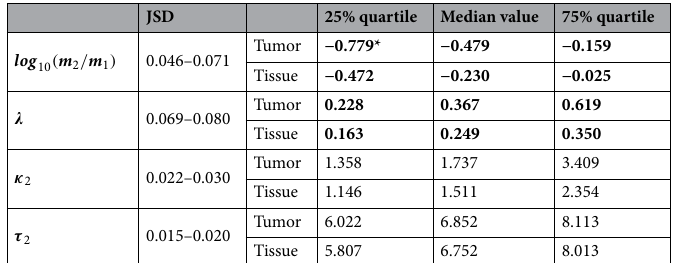
Table 1. Jessen–Shannon divergence ( JSD ) and quartiles for quantifying the differences of parameter values. *The bolded description represents that there is a one-quartile difference in parameter values between tumor and tissue.